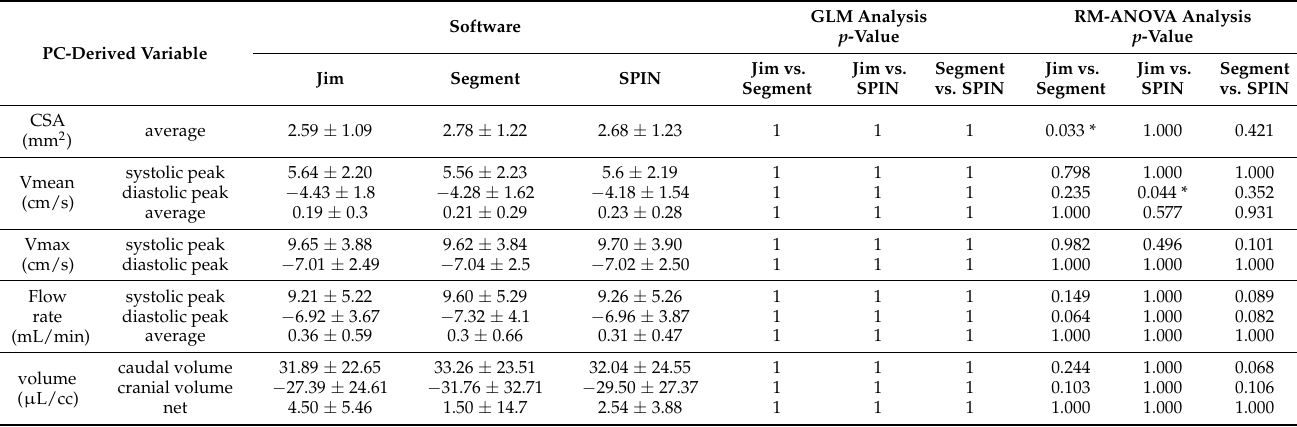
Table 4. PC-derived variables, compared among software packages using a general linear model covaried by age and sex. The mean values and standard deviations are grouped by software and by group; the Bonferroni-corrected p -values of the pair-wise comparisons are also